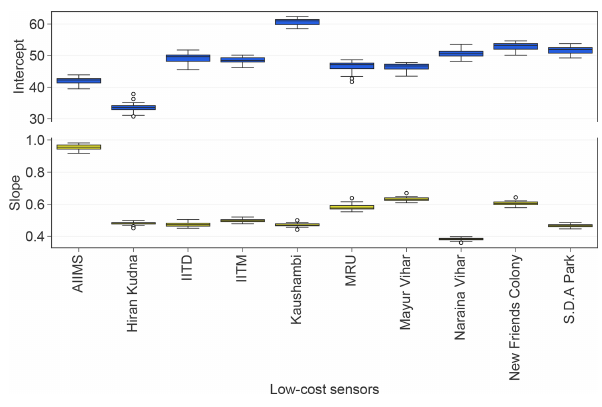
Figure 6. Box plots of the learned calibration factors (i.e., intercept and slope) for each individual low-cost node from the 22 optimized GPR models across the 22-fold leave-one-out